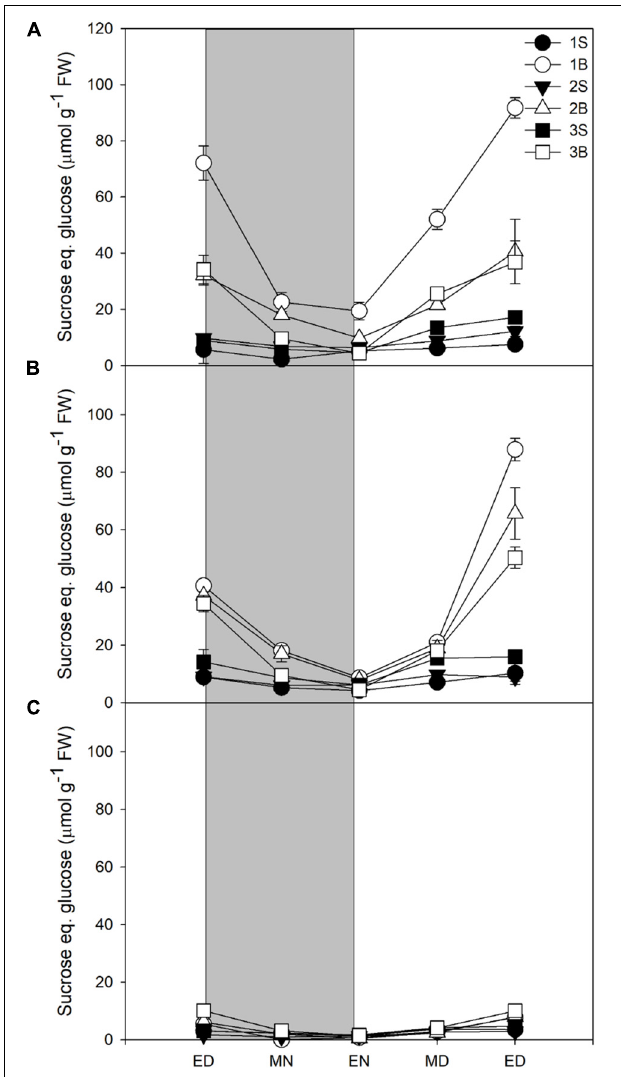
FIGURE 1 | Diurnal sucrose levels of barley cv. Propino plants grown under three light intensities. Sucrose levels of plants grown for (A) 14 DAS under 500 µ mol photons m − 2 s − 1 (HL), (B) 16 DAS under 300 µ mol photons m − 2 s − 1 (ML) and (C) 18 DAS under 100 µ mol photons m − 2 s − 1 (LL), until third leaf stage. Plants were grown in a 16 h:8 h light:dark photoperiod 22 ◦ C:18 ◦ C day:night. 1S: 1st leaf sheath; 1B: 1st leaf blade; 2S: 2nd leaf sheath; 2B: 2nd leaf blade; 3S: 3rd leaf sheath; 3B: 3rd leaf blade; ED: end of day; MN: middle of night; EN: end of night; MD: middle of day; ED2: end of subsequent day; FW: fresh weight; gray panels: night period; error bar represents SD; n = 3. Statistical analyses were performed to assess differences between time points, tissues and light treatments by ANOVA with Tukey’s post hoc test P < 0.05, and results are available in Supplementary